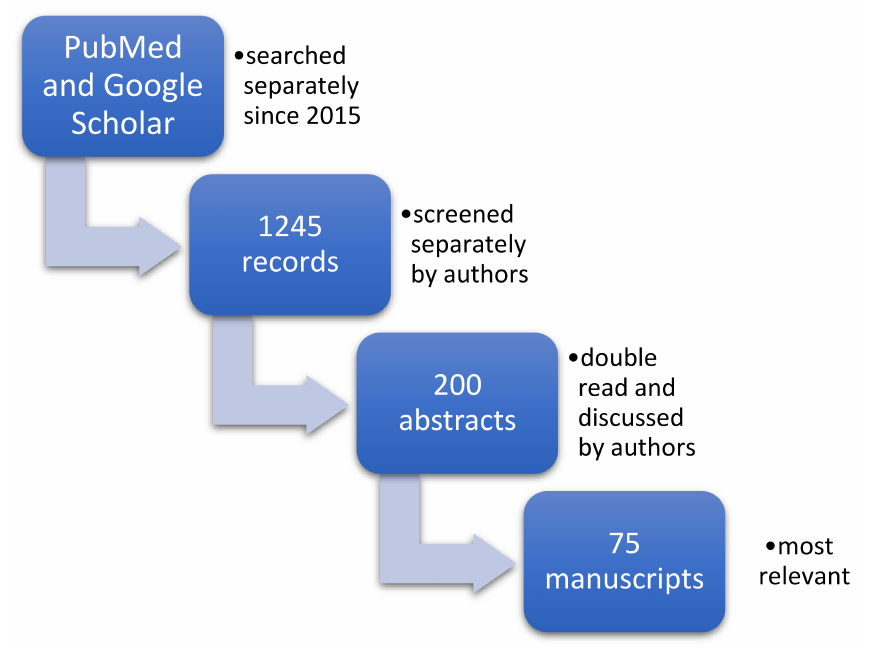
Figure 1. The process of data